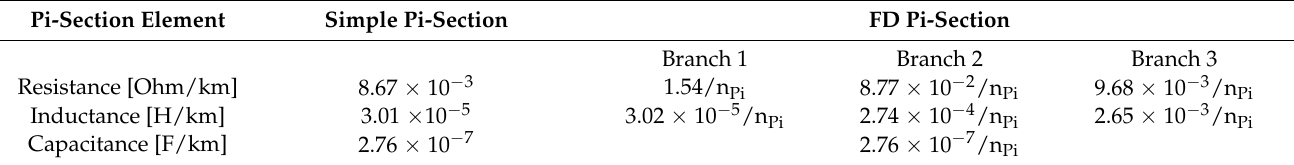
Table 2. Equivalent simple and FD-Pi Section values.